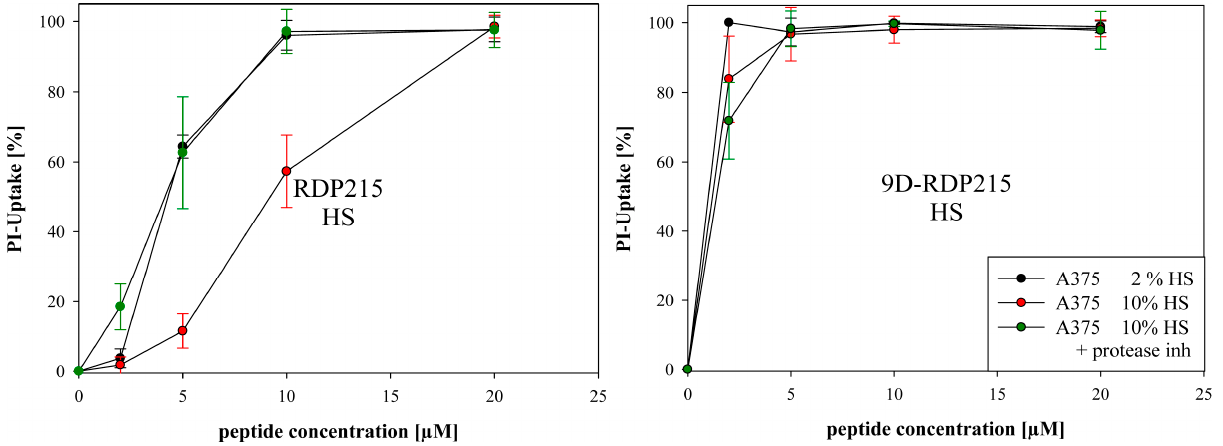
Figure 10. The toxicity of RDP215 and 9D-RDP215 on malignant melanoma cell line A375 in the presence of 2% and 10% human serum (HS). Cell death (%) was determined by PI-uptake in the presence of 2 µM, 5 µM, 10 µM and 20 µM peptide concentration upon 8 h of incubation in the presence of 2% HS (black circles), 10% HS (red circles) and 10% HS with the protease inhibitor (green circles), respectively. The protease inhibitor was added to the cells prior to peptide incubation. Both peptides show high activity for melanoma cells, and the L-peptide exhibits reduced activity in the presence of higher amounts of human serum. In the presence of the protease inhibitor, the activity is restored. Compared, the D-peptide shows increased toxicity on melanoma independent of the concentration of serum. Data represent mean values of at least 3 independent experiments with standard deviation given.